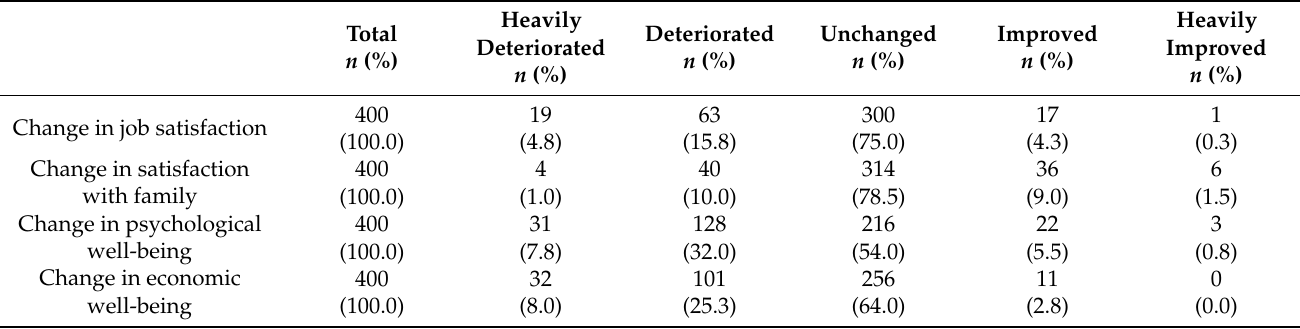
Table 1. Frequency distribution of the dependent